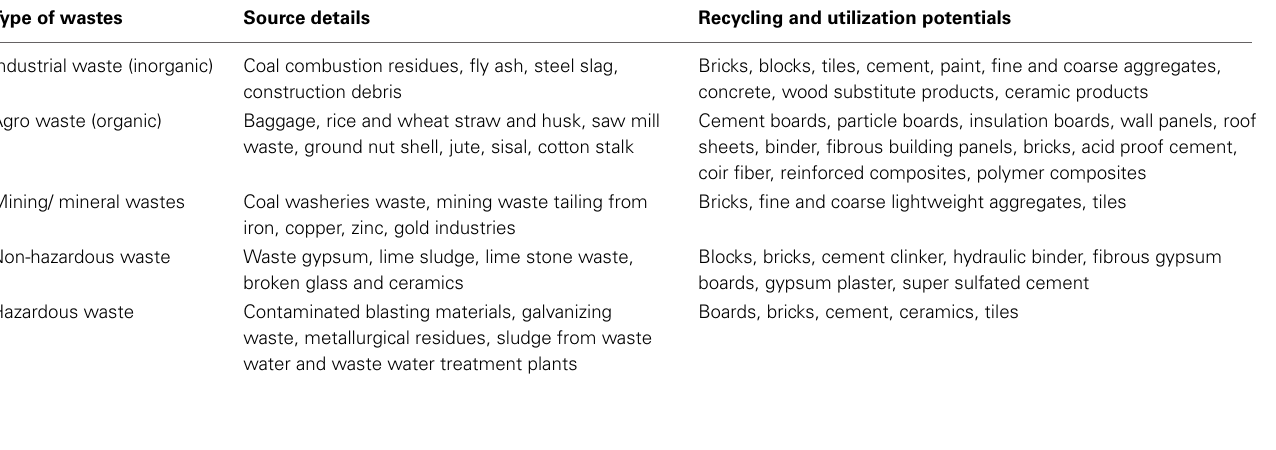
Table 5 | Different types and sources of solid wastes and their recycling and utilization potentials for construction materials (adapted from Pappu et al.,